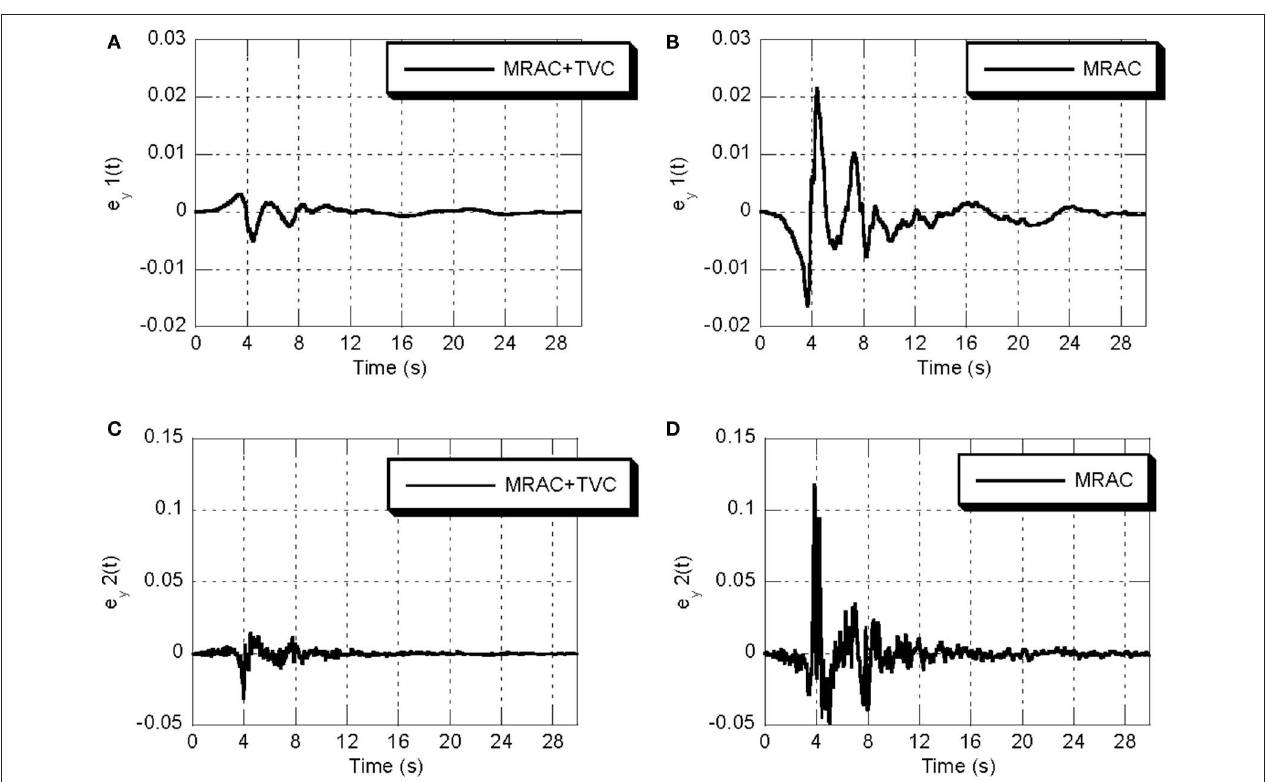
FIGURE 10 | Comparison of tracking error convergence of adaptive algorithm for the Northridge earthquake. (A , C) Using combined strategy. (B , D) Using only MRAC.